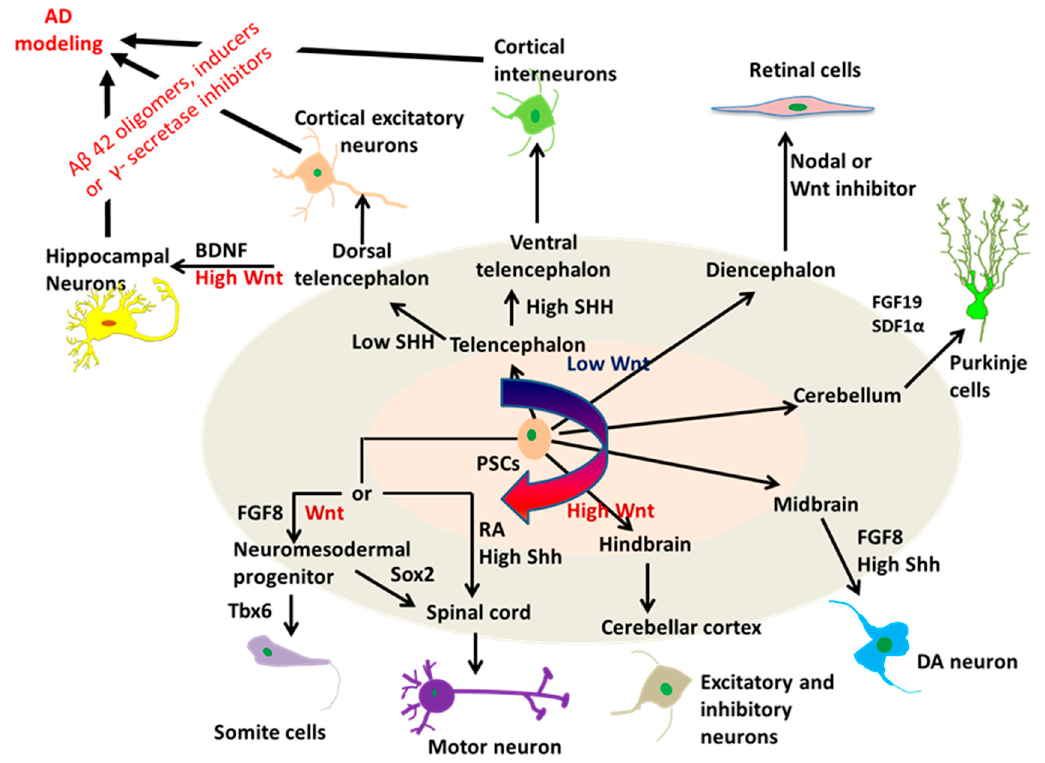
Figure 3. Regional specification in neural differentiation of pluripotent stem cells (PSCs) mimicking in vivo regional patterning, and the use of the derived forebrain organoids for AD modeling. The regional patterning of brain organoids was achieved by cell signaling modulators and the corresponding organoids generated were used for disease modeling. DA: dopaminergic; FGF: fibroblast growth factor; RA: retinoic acid; SHH: Sonic Hedgehog; BDNF: Brain-derived neurotropic growth factor; SDF: Stromal cell-derived factor. Adapted and revised from [81].